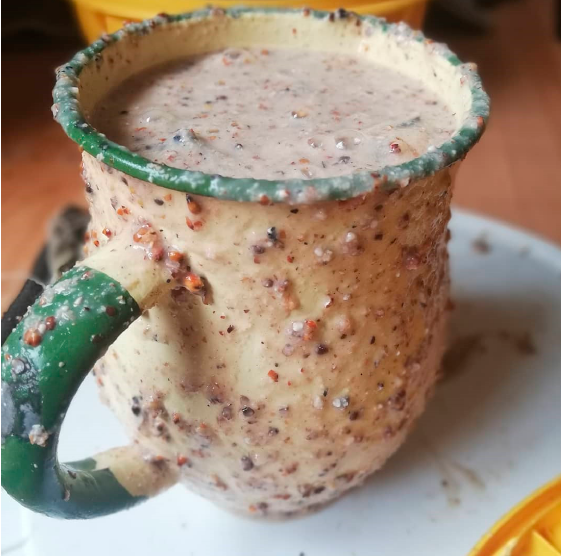
Figure 1. Umqombothi (South African traditional beer) served in a cup.